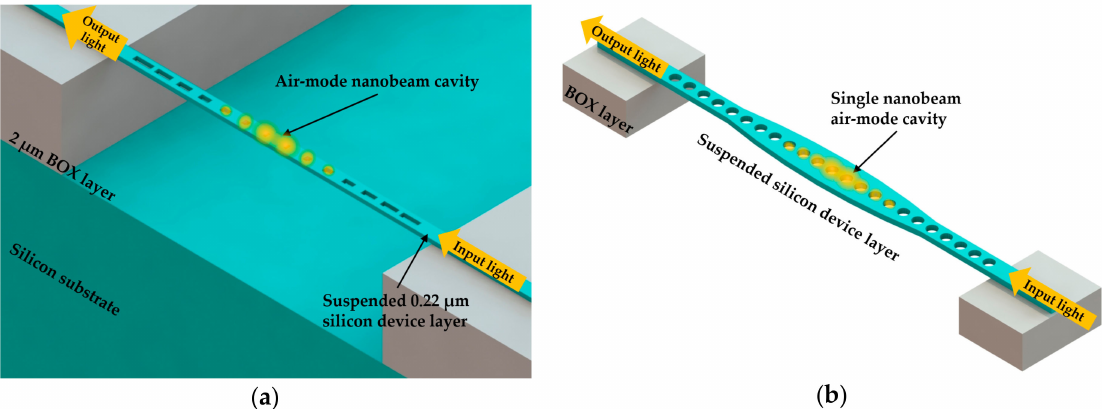
Figure 8. Air mode nanobeam cavities that localize light in low index region: ( a ) nanobeam cavity with modulated air holes; ( b ) nanobeam cavity with modulated